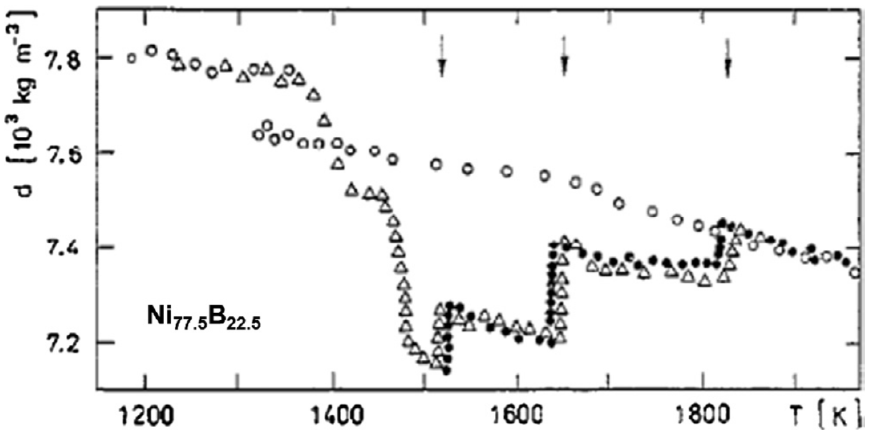
Figure 3. Temperature dependence of the density d of Ni-22.5%B melt at slow heating after melting and time exposition for 5–20 h ( • ), subsequent cooling (o), and the second heating after crystallization of the sample and repeated melting ( ∆ ). The arrows show the “critical” temperatures at which the density instability is observed. Reprinted with permission from ref. [24], Copyright 1997